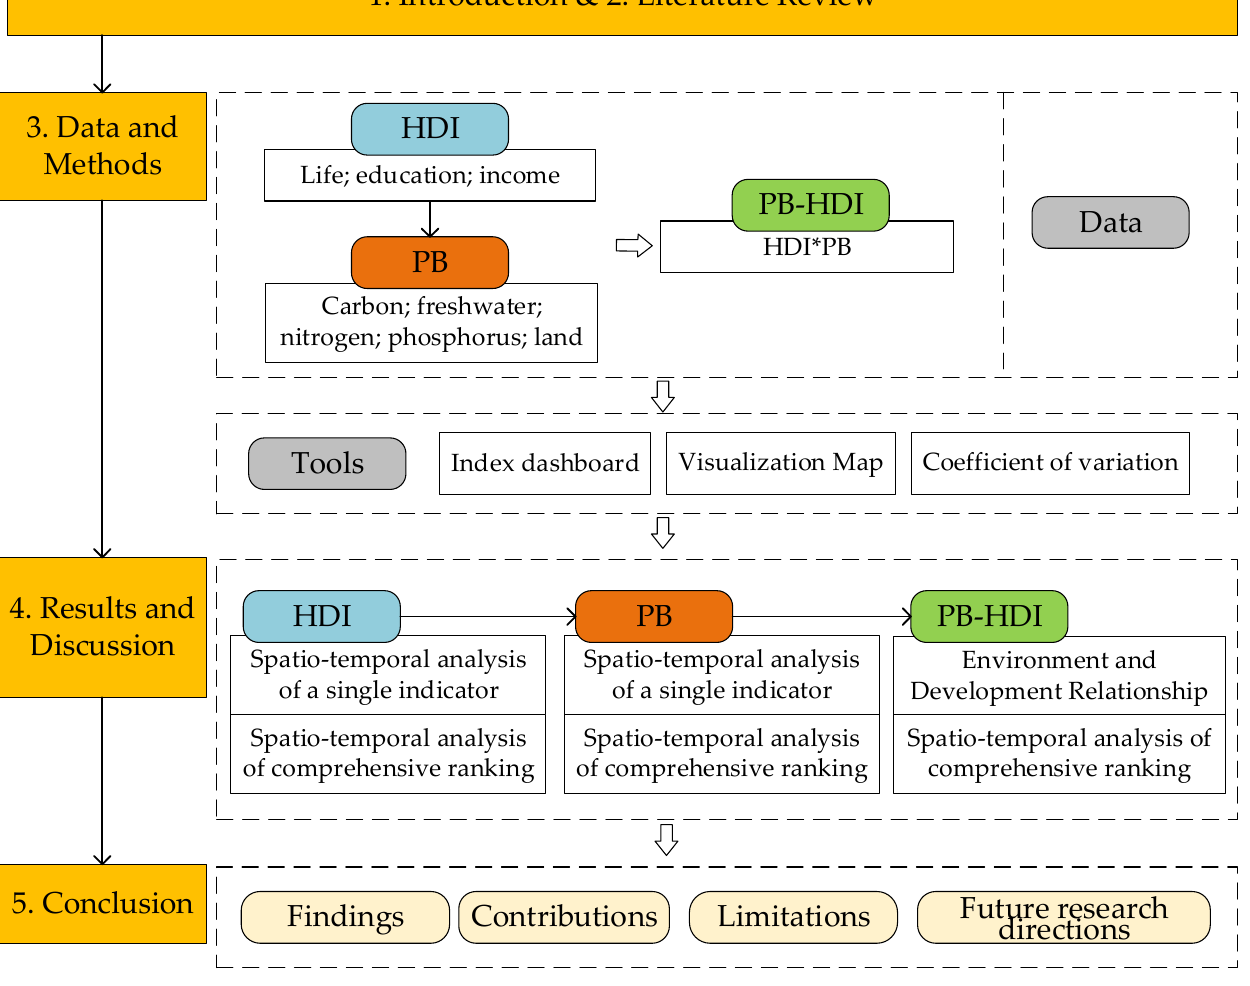
Figure 2. Flowchart of the research in this paper.